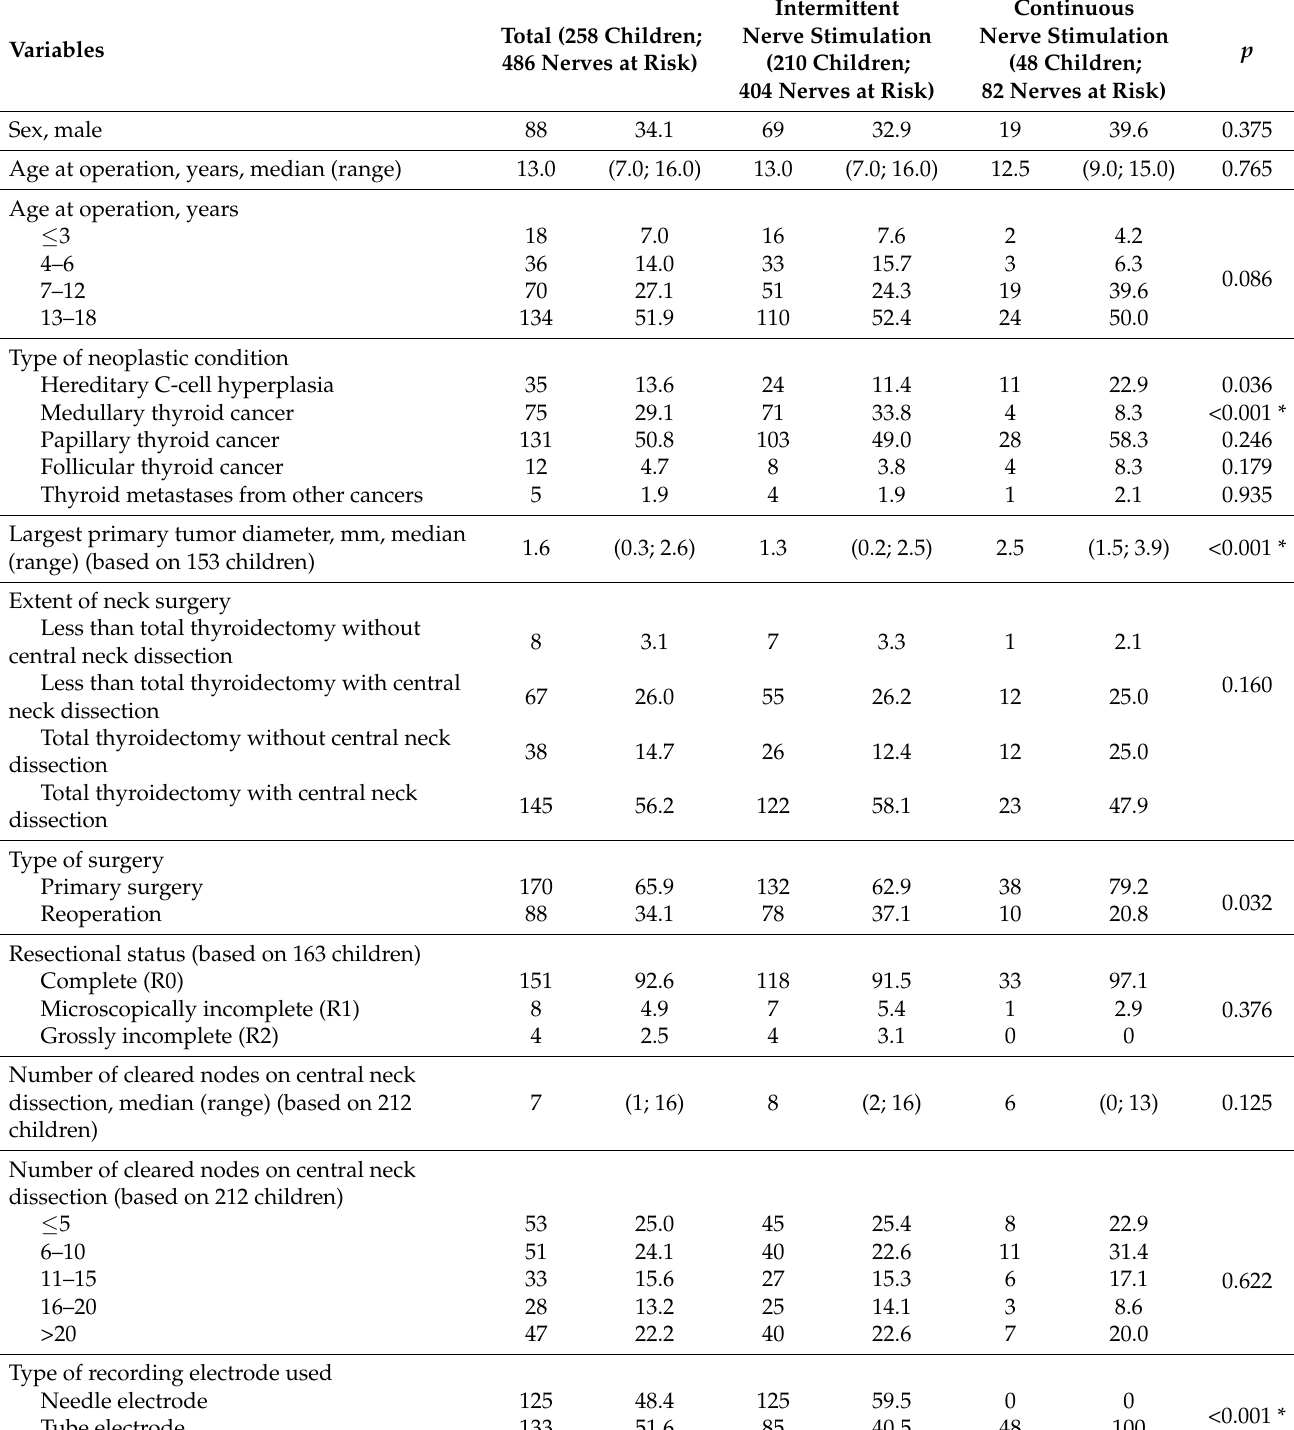
Table 1. Demographics, thyroid histopathology, extent, type, and completeness of pediatric oncological thyroidectomy by type of intraoperative nerve